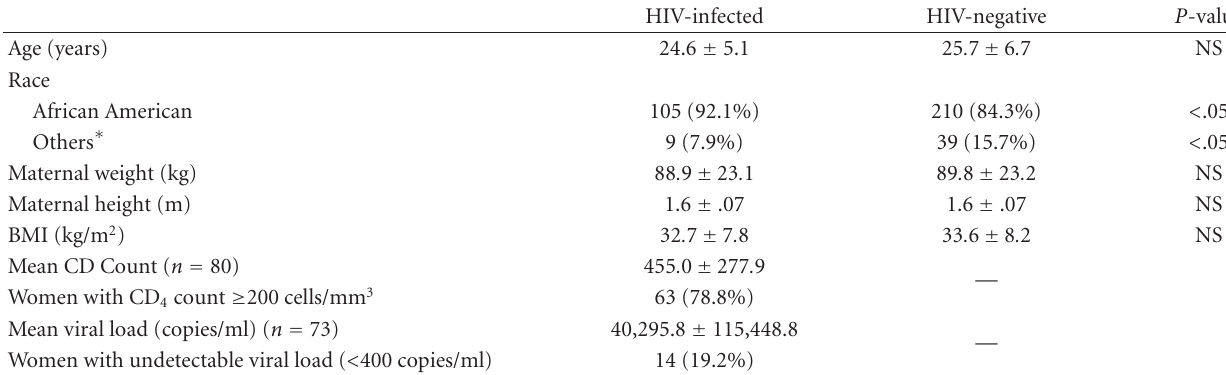
Table 1: Maternal characteristics.